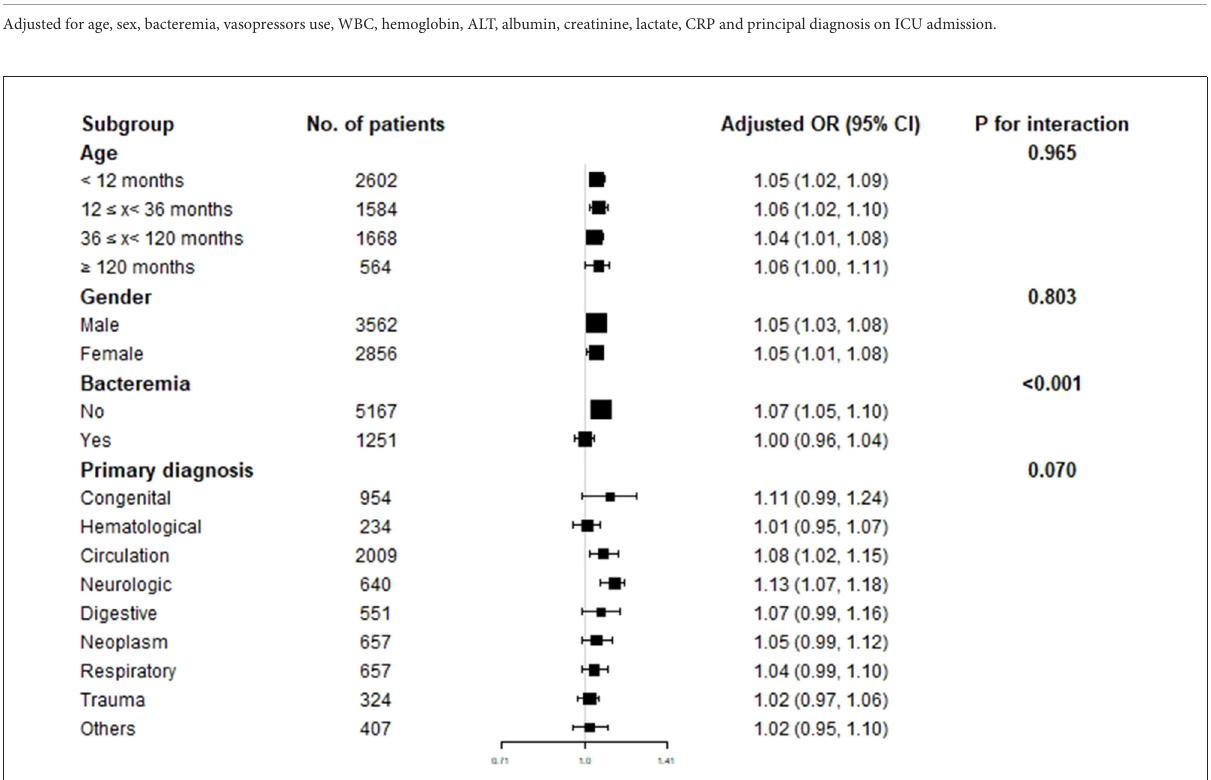
FIGURE3 Subgroup analysis of the association between D-dimer and in-hospital